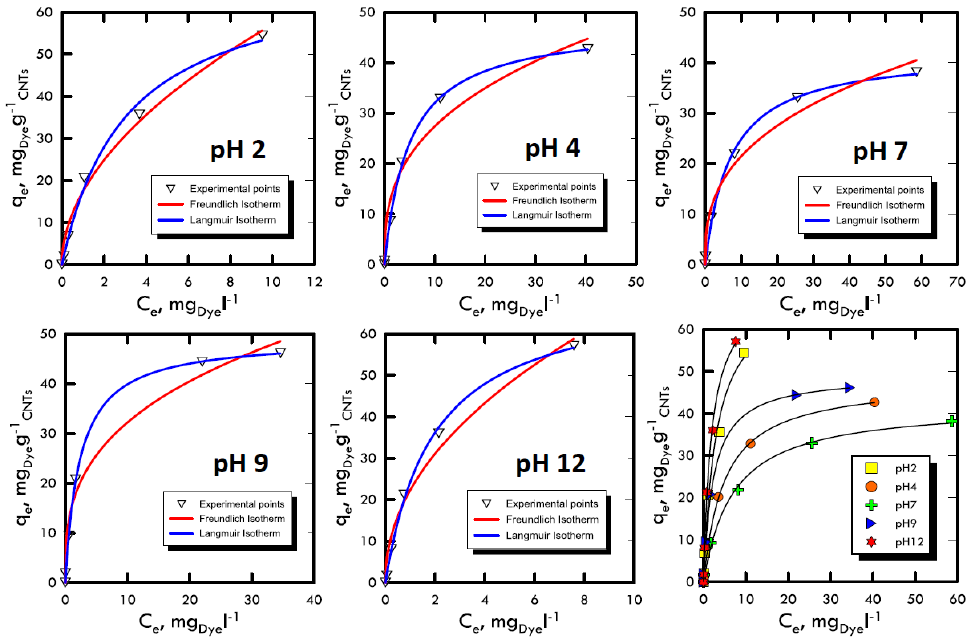
Figure 6. Adsorption isotherm for Reactive Blue 116 at different pH values. Table 5. Return of adsorption isotherm data for Reactive Blue 116.